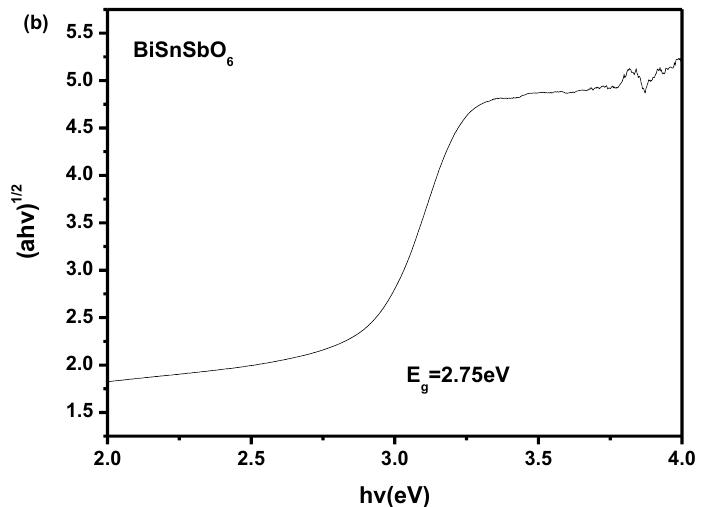
Figure 7. ( a ) The diffused reflection spectrum of BiSnSbO 6 ; ( b ) Correlative diagram of ( αhν ) 1/2 and hν for BiSnSbO 6 .